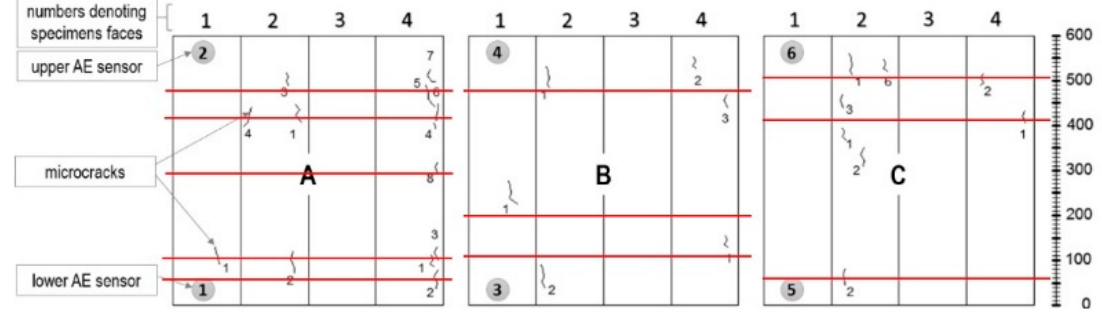
Figure 8. Surface microcracks distribution on sides of the W4 samples. Linear location of destructive processes III (AE signal class 3) in W4 samples obtained by the AE method is marked in red.